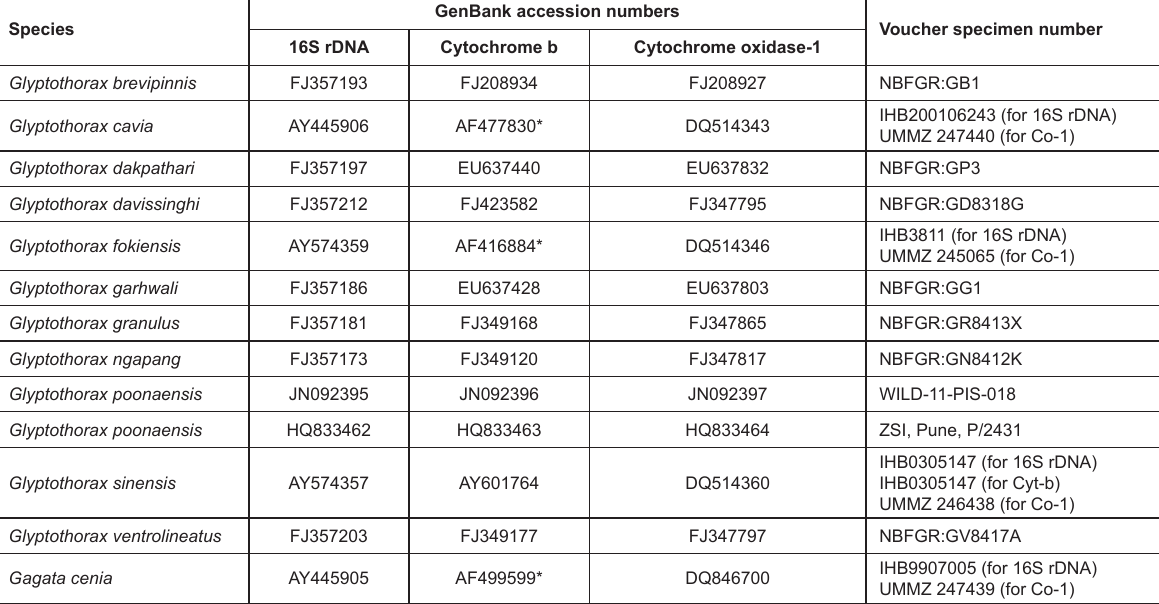
Table 2. GenBank details of gene sequences used for phylogenetic analysis Species